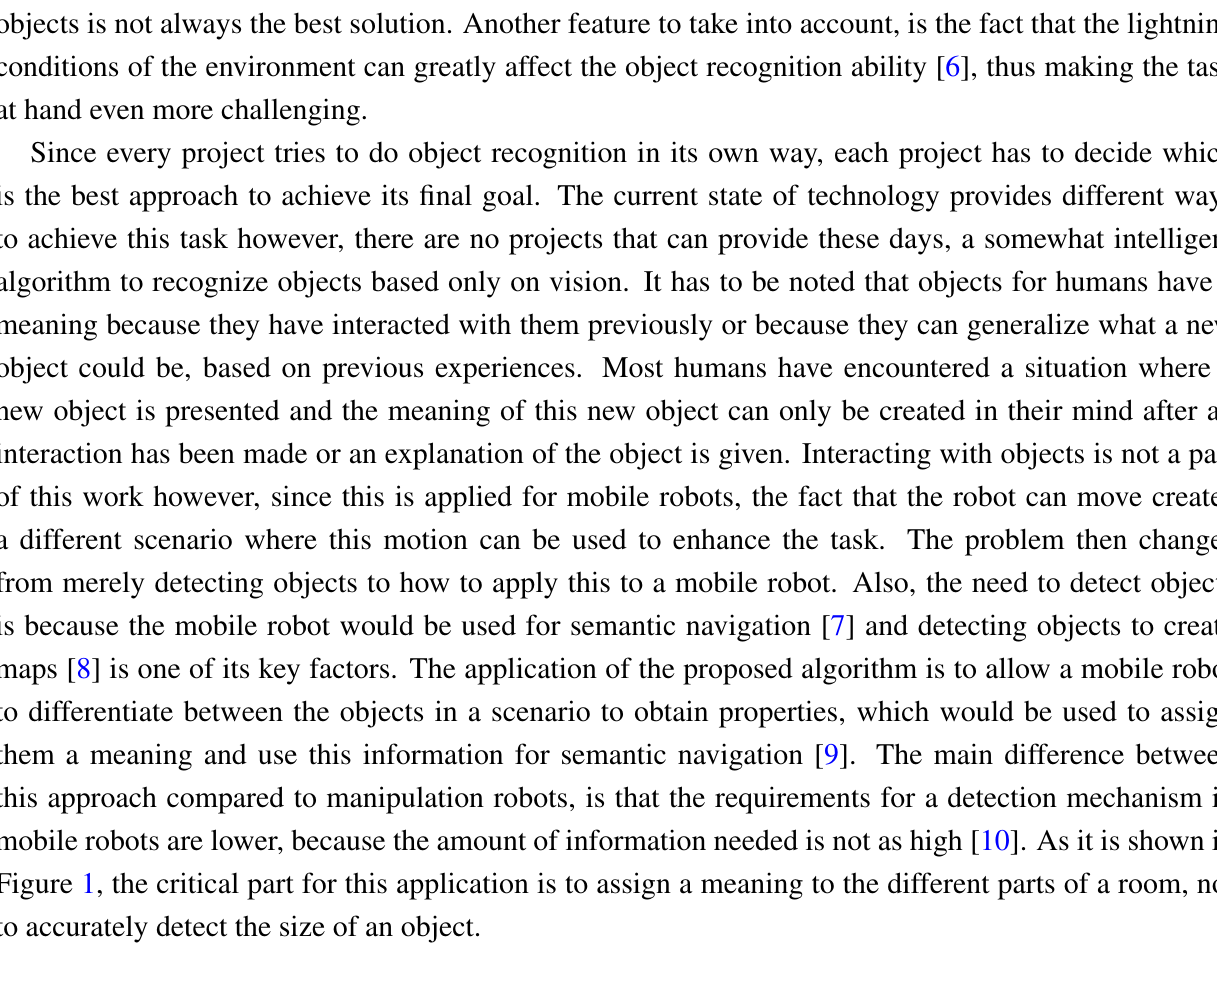
Figure 1. Differentiate between objects in environment